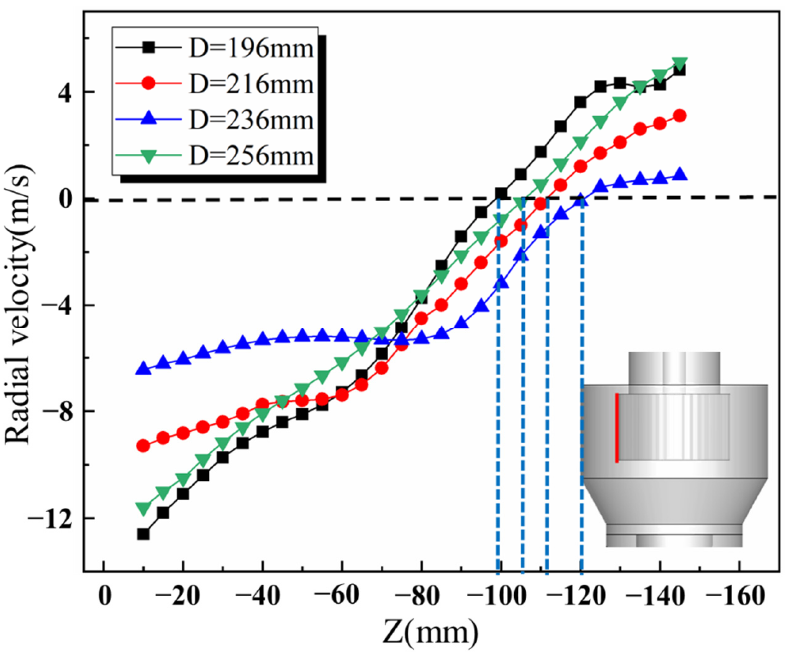
Figure 14. Effect of the guide cone diameter on the axial velocity of the rotor cage entrance.